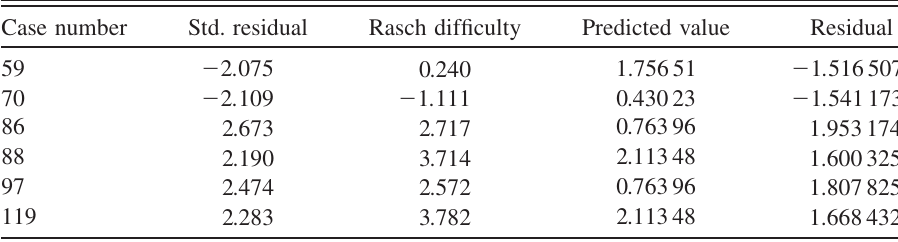
TABLE VIII. Casewise diagnostics a